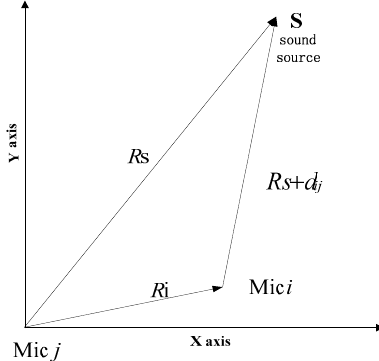
Figure 9. Diagram illustrating geometric relations among m i , m j and S .